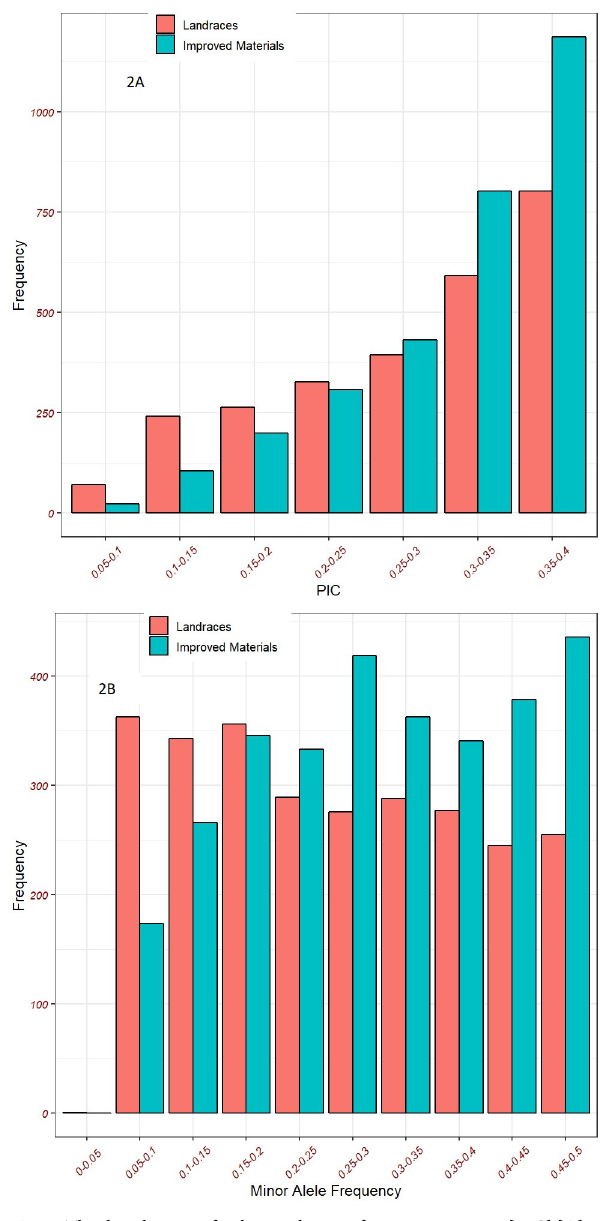
Fig 2. The distribution of polymorphism information content [PIC] [A] and allele frequency [B] for the improved accessions and